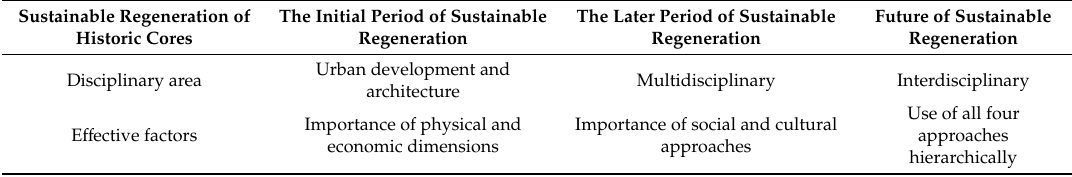
Table 3. The evolution process of sustainable regeneration of the historic core of